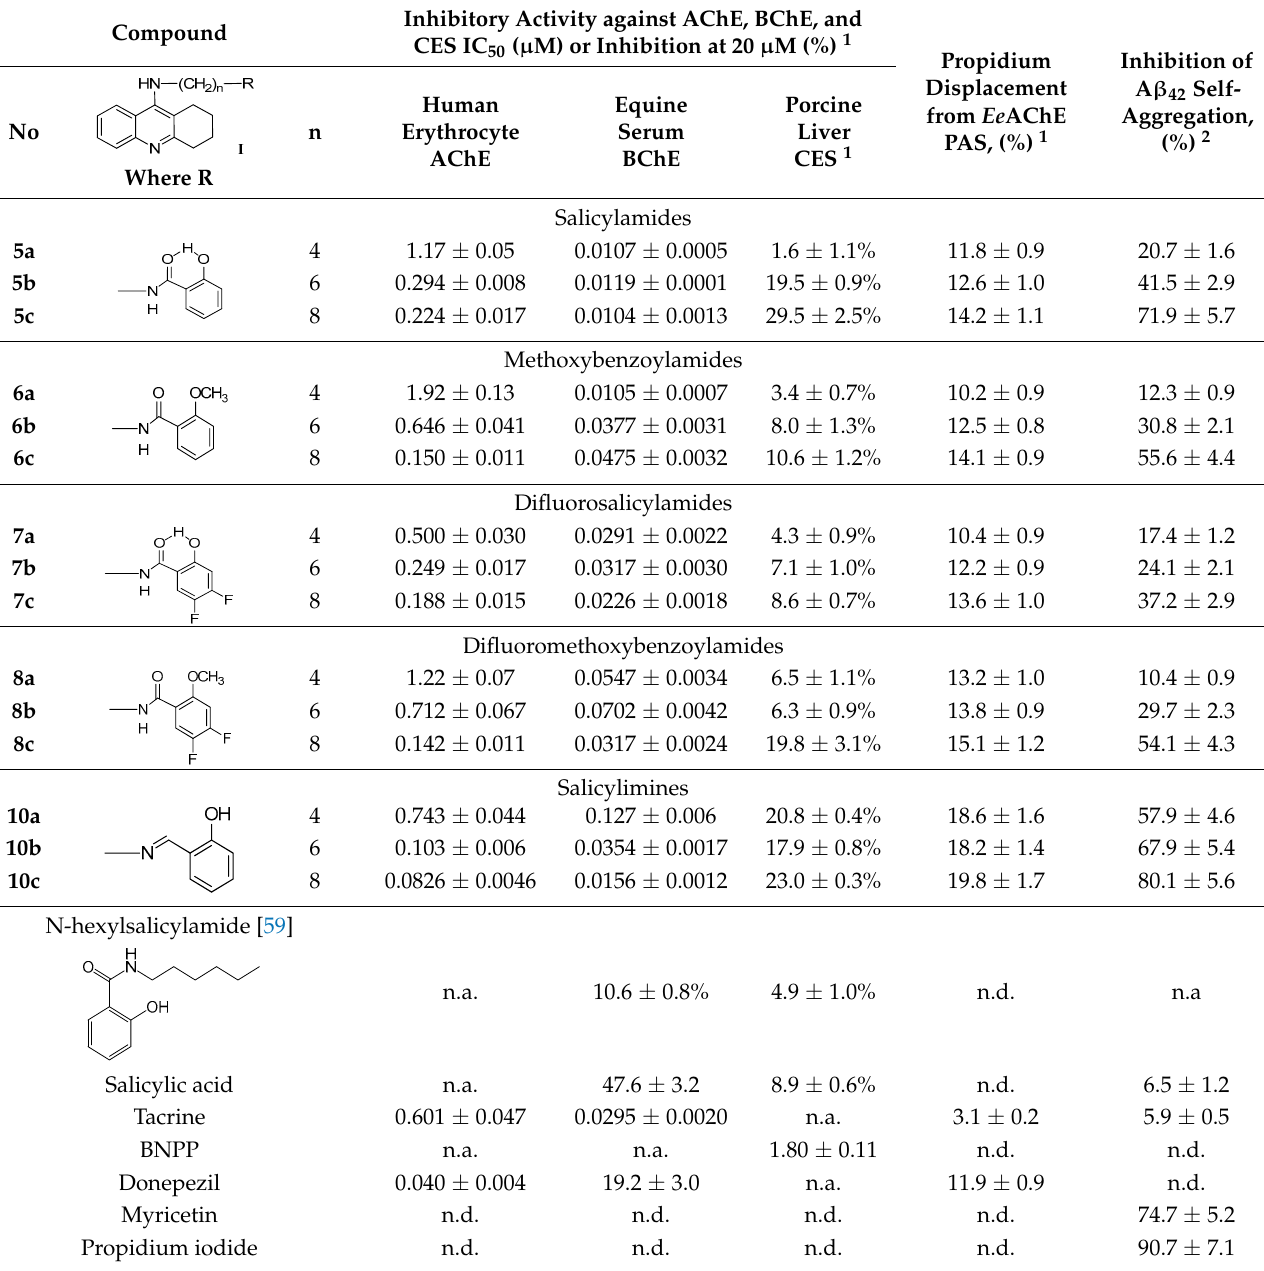
Table 1. Esterase profiles of conjugates 5 – 8 , 10 of general formula ( I ), their ability to displace propidium from the Ee AChE PAS, and their inhibition of A β 42 self-aggregation.